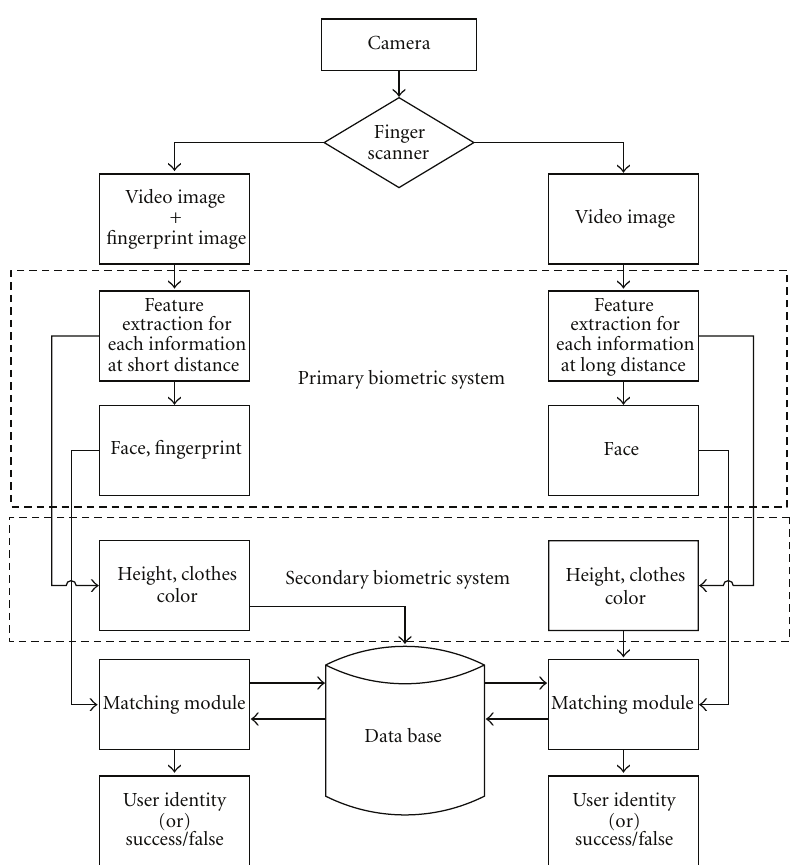
Figure 10: Proposed framework of the human identification at a distance.